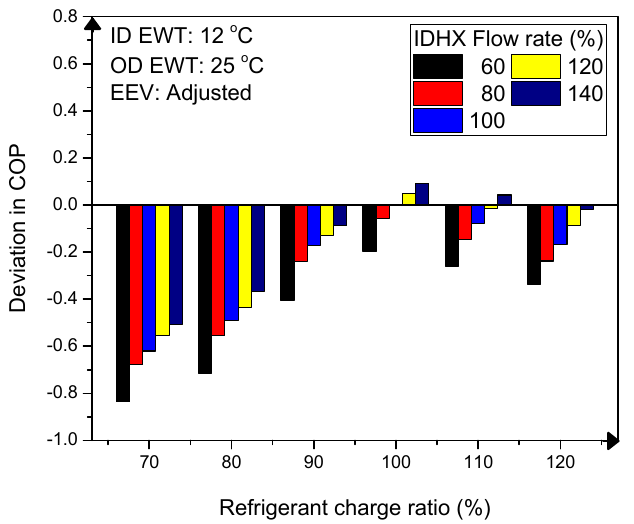
Figure 4. Deviation in COP according to refrigerant charge and indoor heat exchanger flow rate combined faults.